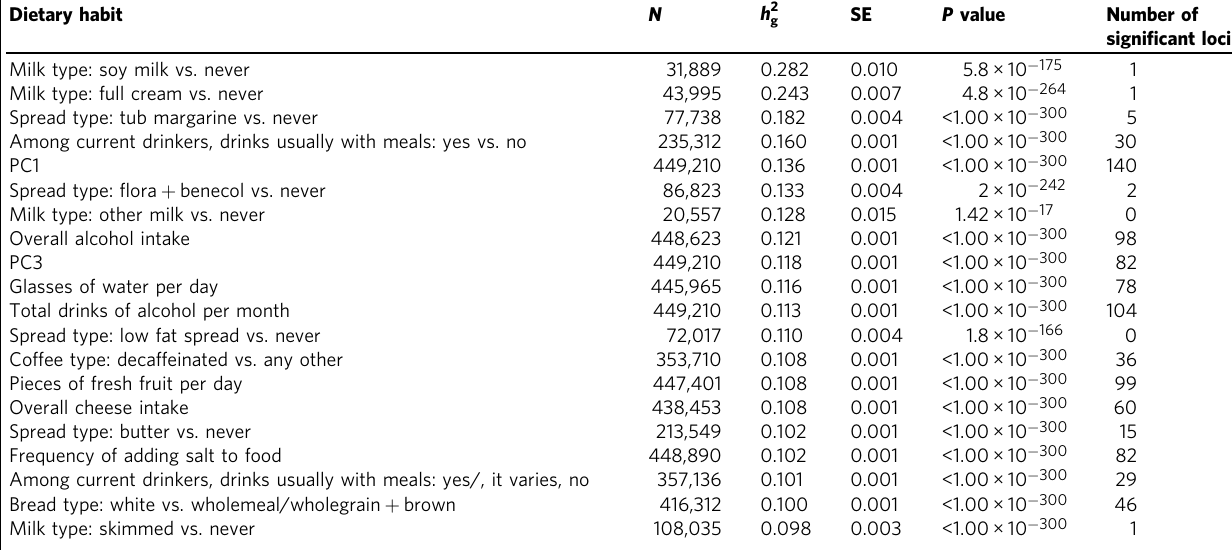
Table 1 SNP heritability estimates h 2